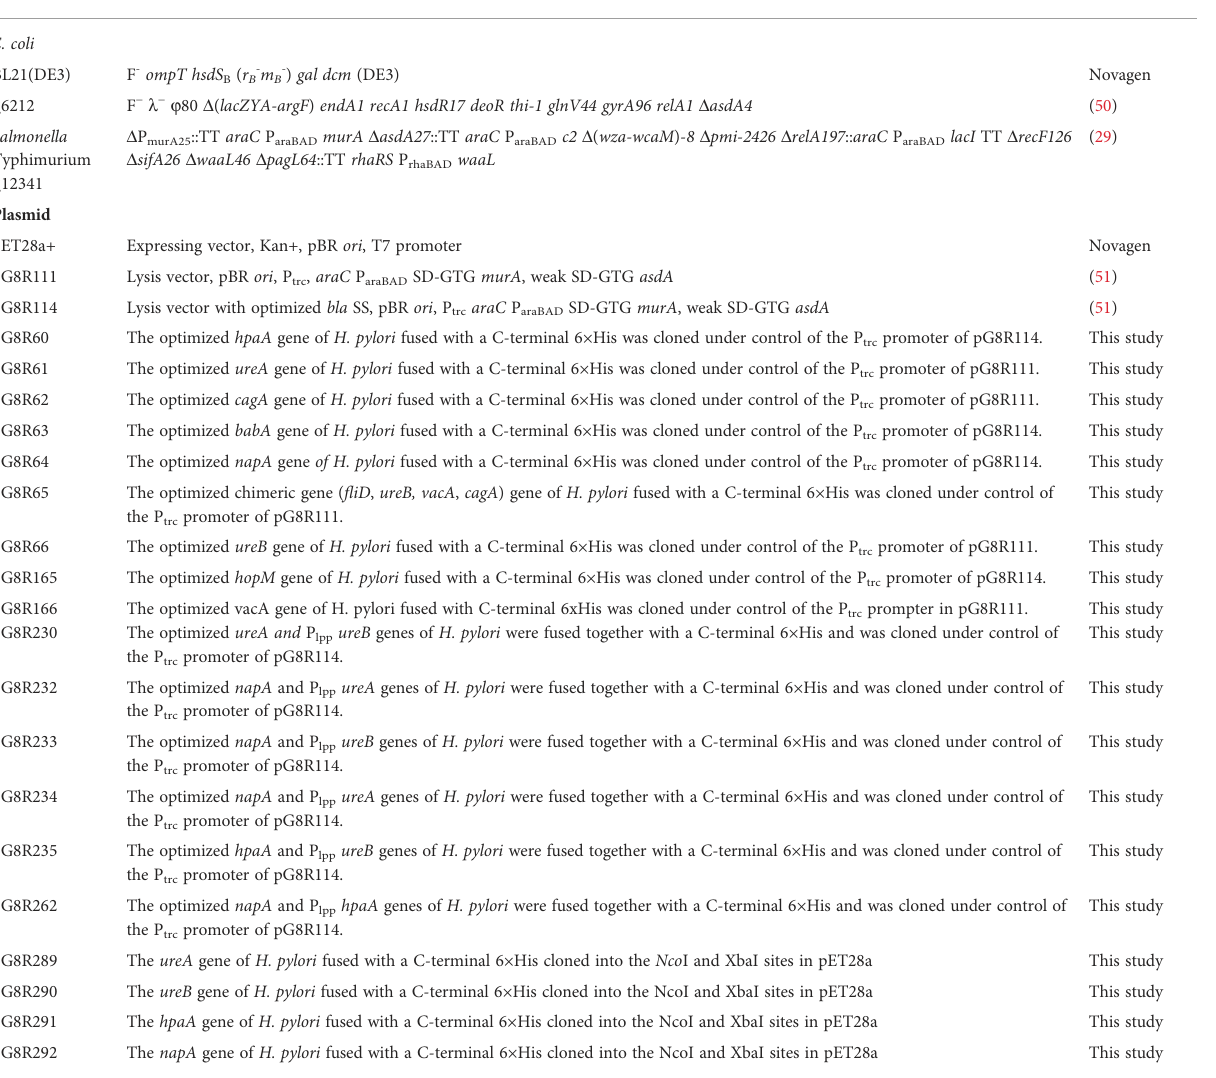
TABLE 1 Plasmids and strains used in this study. Strain or